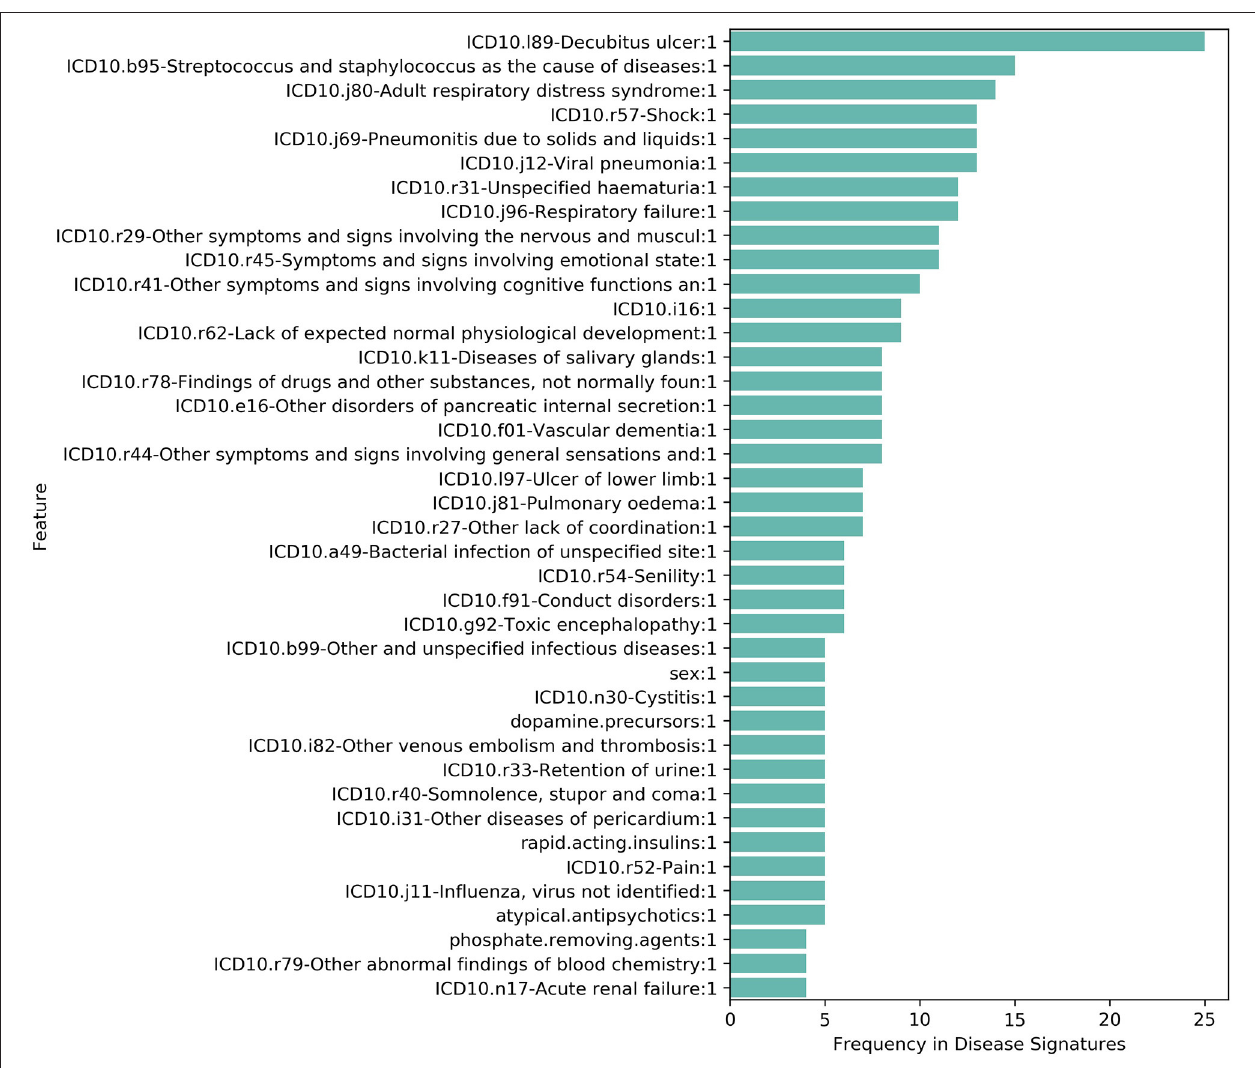
FIGURE 1 | Phenotypic and clinical features that were most frequently reported (top 40) in 255 filtered disease signatures in Cohort 1 were associated with an increased risk of hospitalization with severe COVID-19.